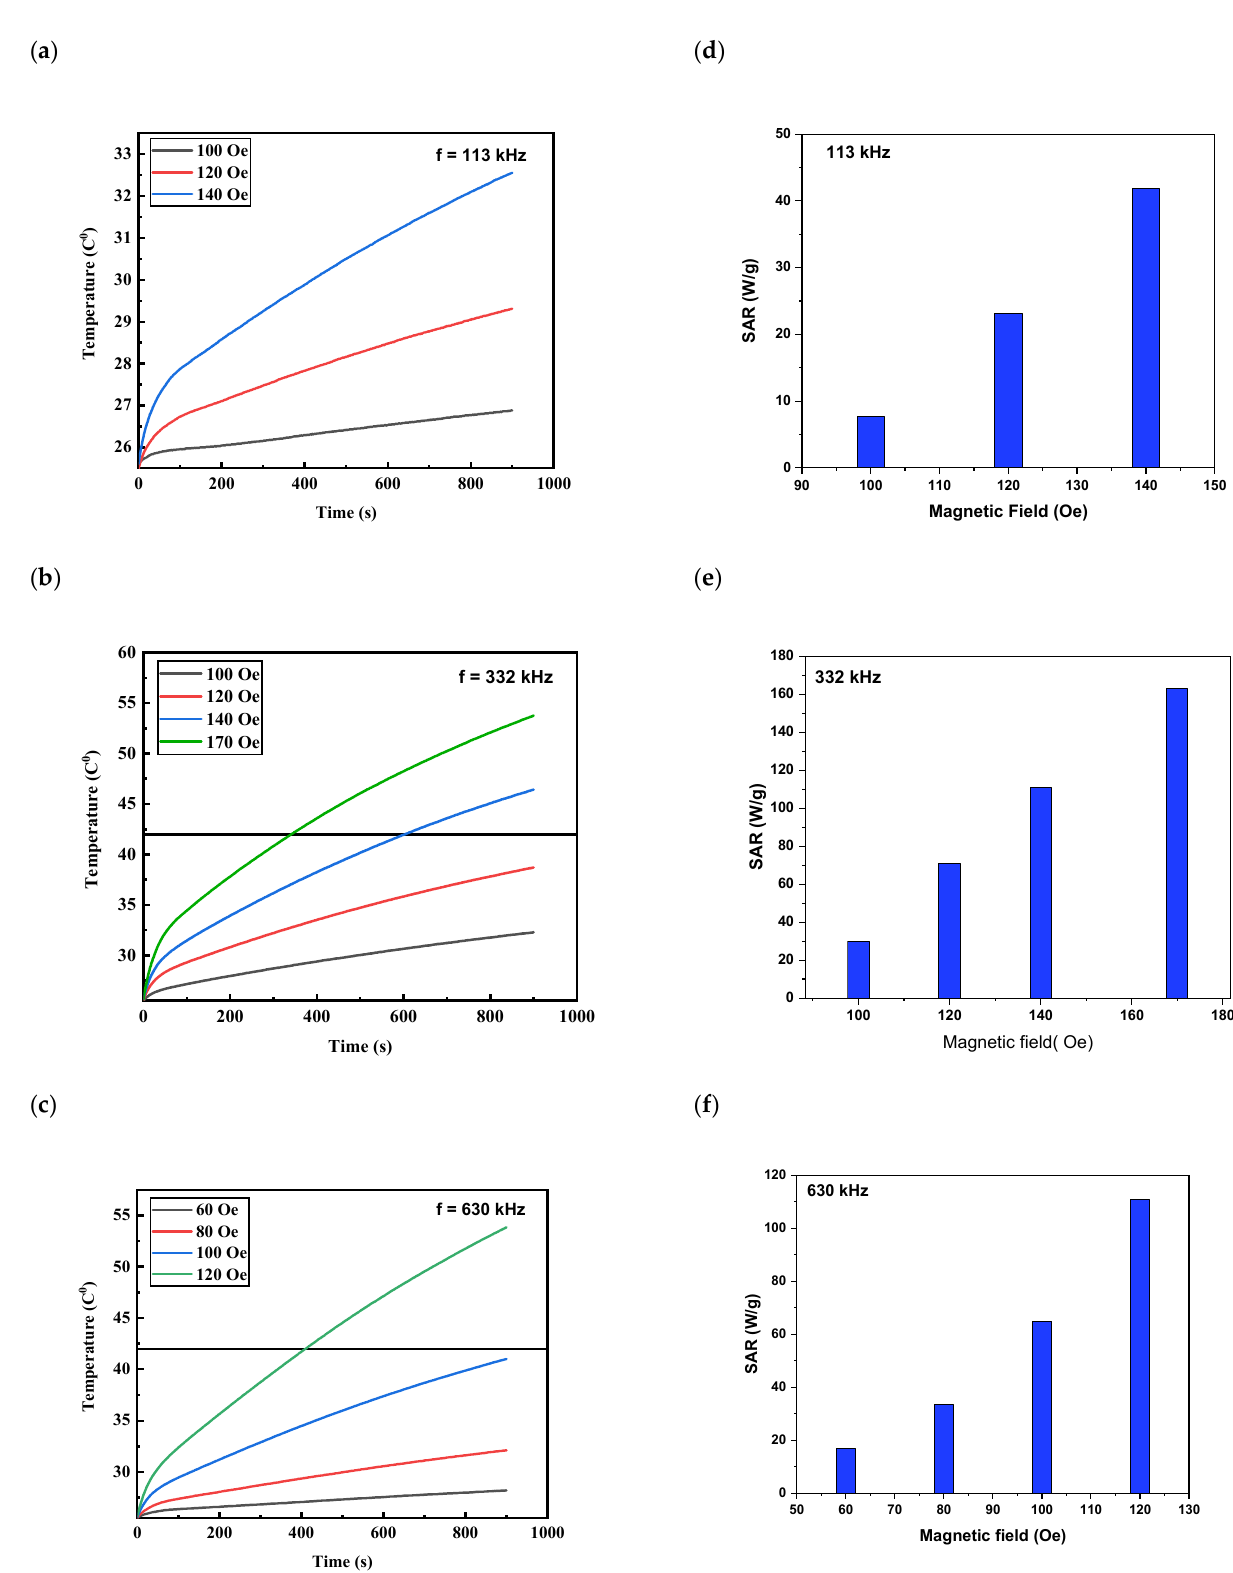
Figure 6. ( a ) Temperature increases at different frequencies and field amplitudes for a concentration of 5 mg/mL ( a – c ) and ( d – f ) SAR values.